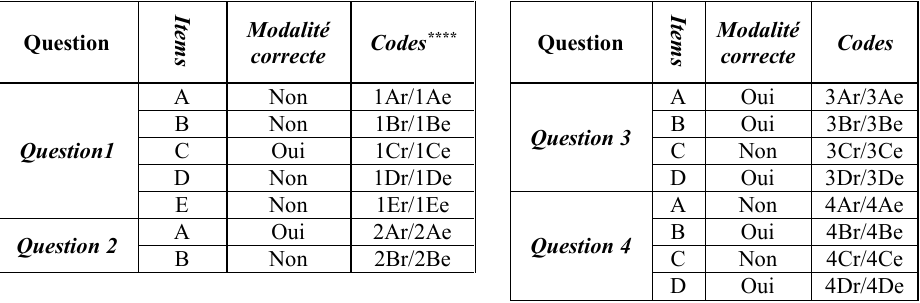
Tableau 2. Codage des modalités des différents items des quatre questions du questionnaire.